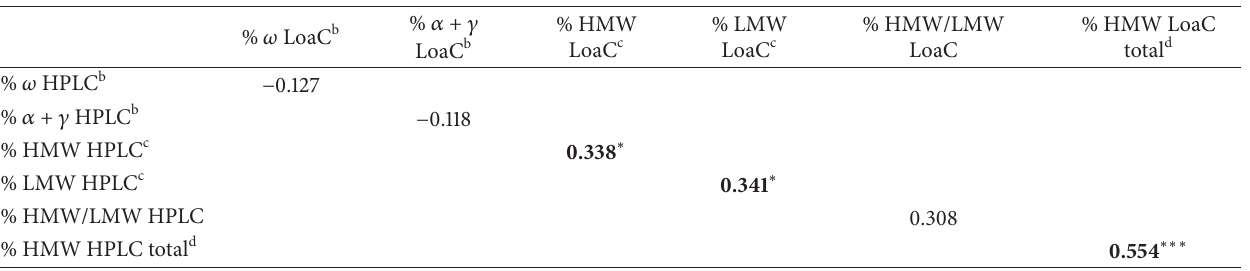
Table 6: Correlation coefficients between relative amounts of gliadin subunits ( 𝛼 + 𝛾 and 𝜔 ) and glutenin subunits (LMW and HWM) determined by LoaC and RP-HPLC methods a